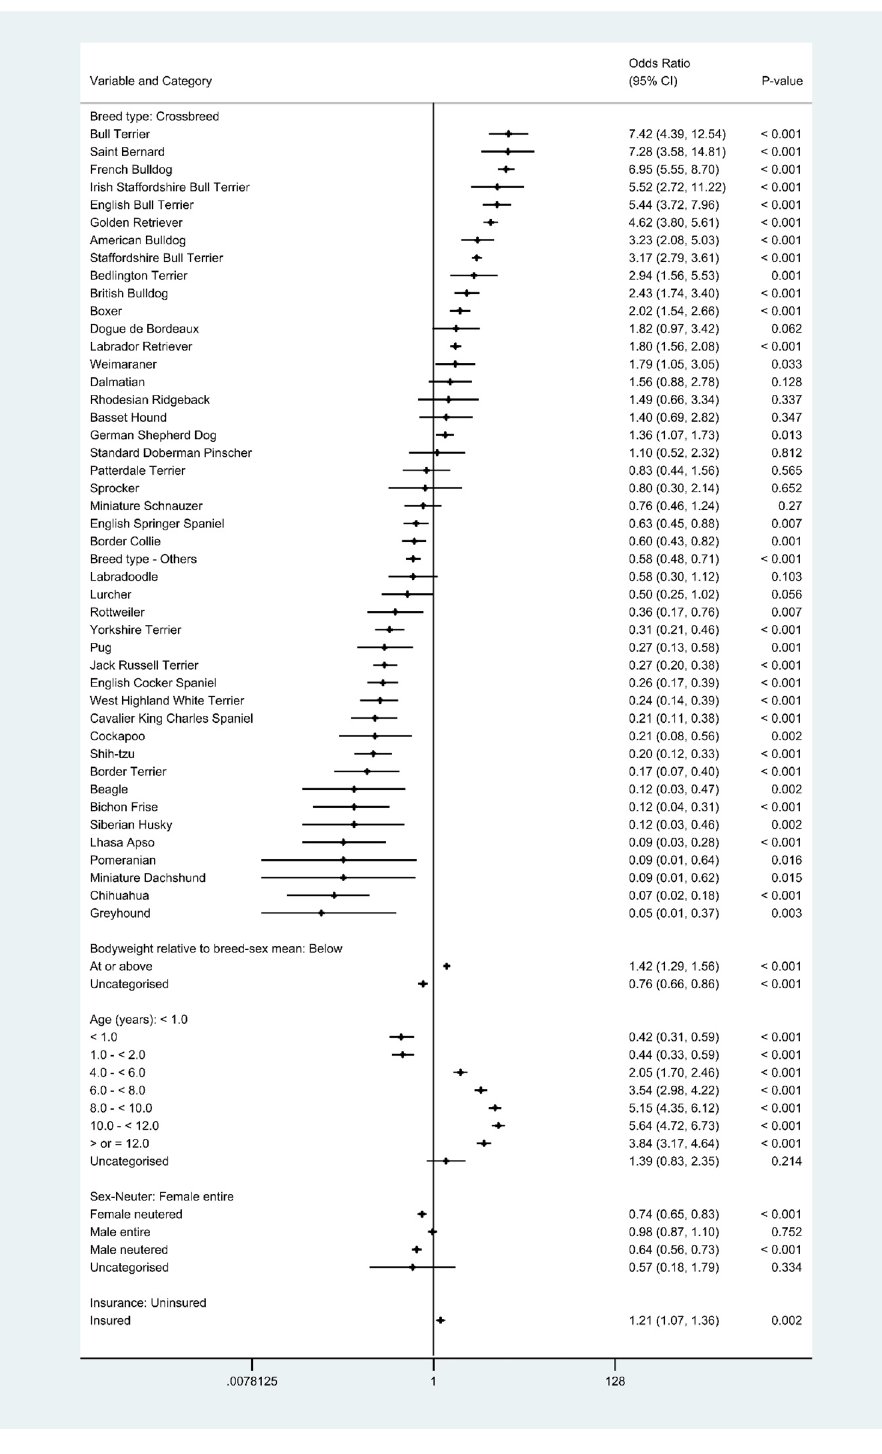
Figure 2. Final breed-focused random effects multivariable logistic regression model for risk factors associated with aural haematoma in dogs under primary veterinary care in the VetCompass™ Programme in the UK. Clinic attended was included as a random effect. *CI confidence